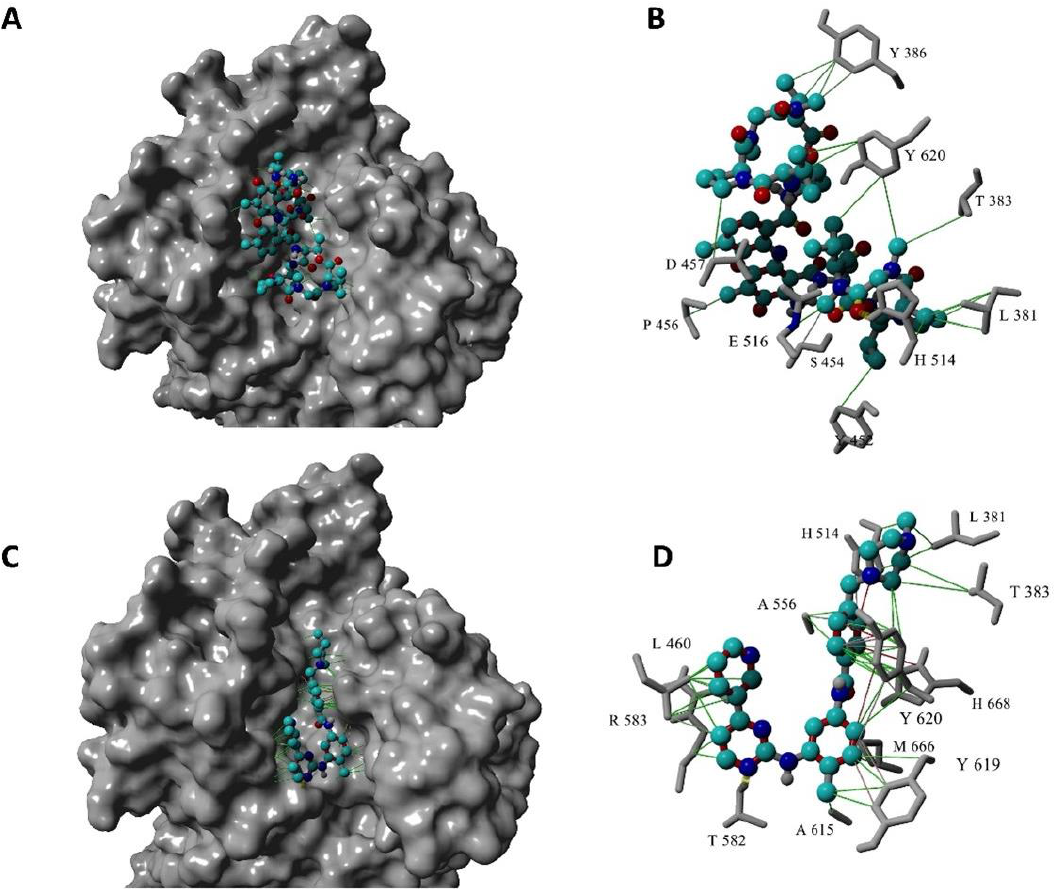
Figure 3. Docking of actinomycin D and imatinib in Agd3. ( A ) Actinomycin D occupies Agd3 catalytic center. ( B ) Interactions of actinomycin D with Agd3 amino acids. ( C ) Imatinib in Agd3 catalytic center. ( D ) Interactions of imatinib with Agd3 amino acids including the catalytic residues His514 and His668.